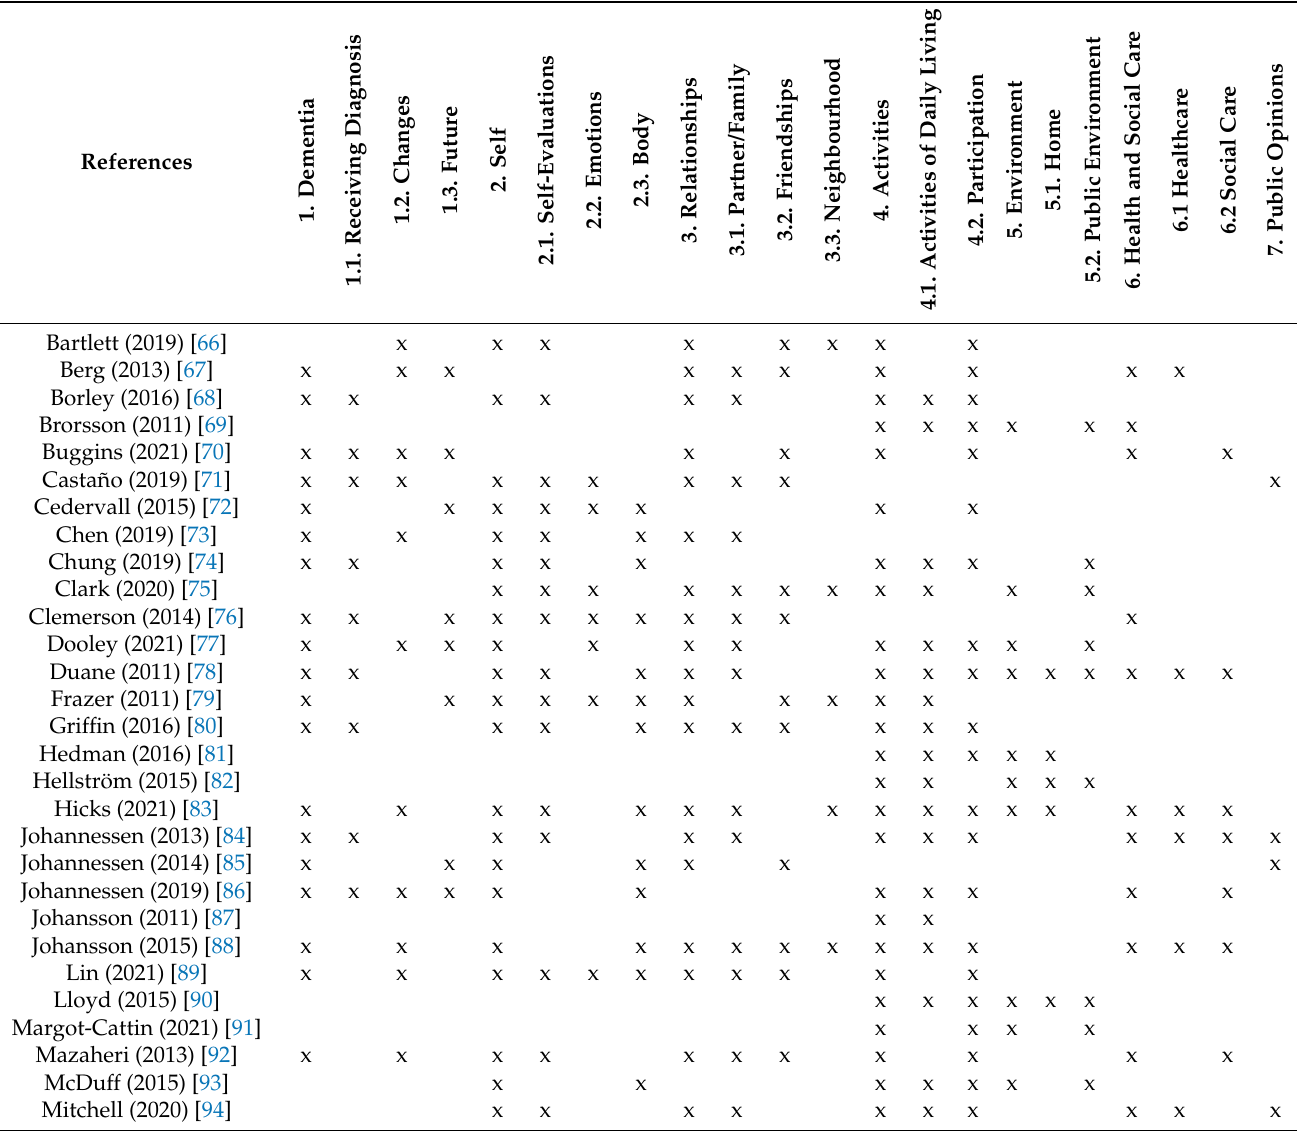
Table 5. Extraction of categories and